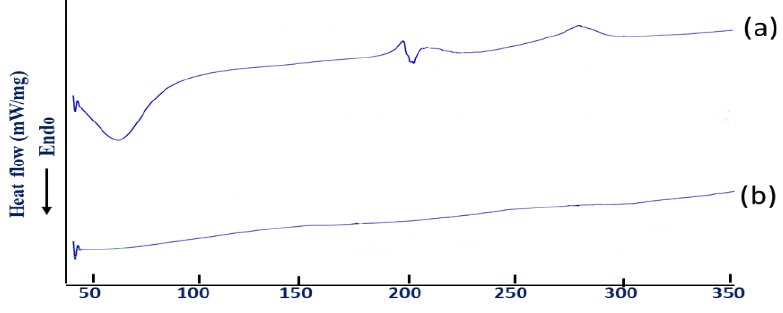
Figure 6. Differential scanning calorimetry (DSC) thermogram of BSO-free beads ( a ) and BSO-loaded beads ( b ).